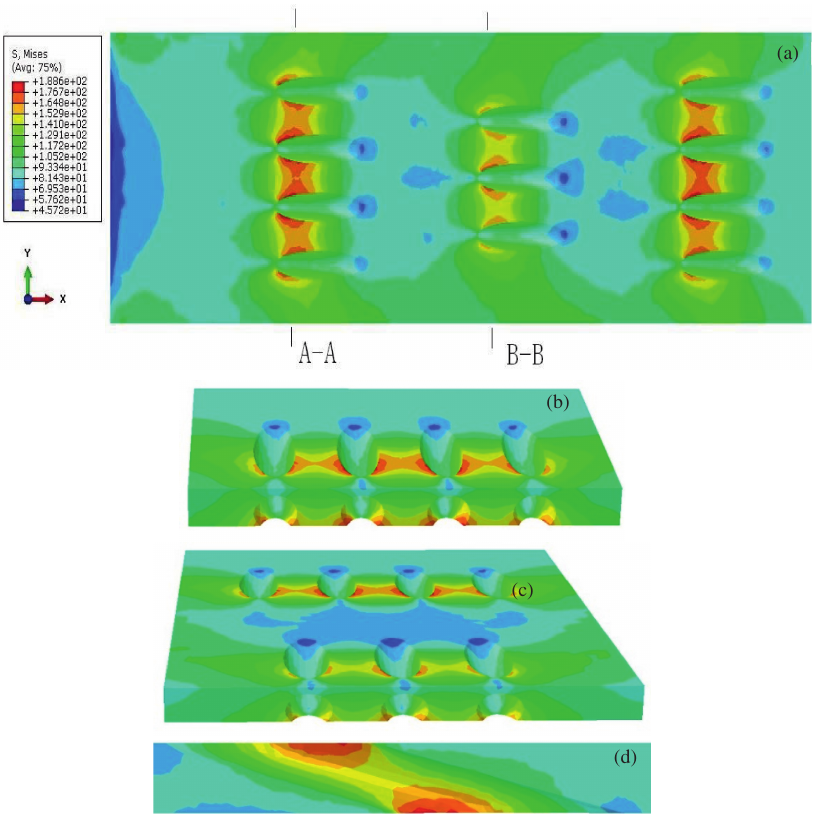
Figure 7: Distribution of equivalent stress when calculation stopped: (a) the whole appearance; (b) the section A – A; (c) the section B – B; and (d) the stress distribution of inner hole.